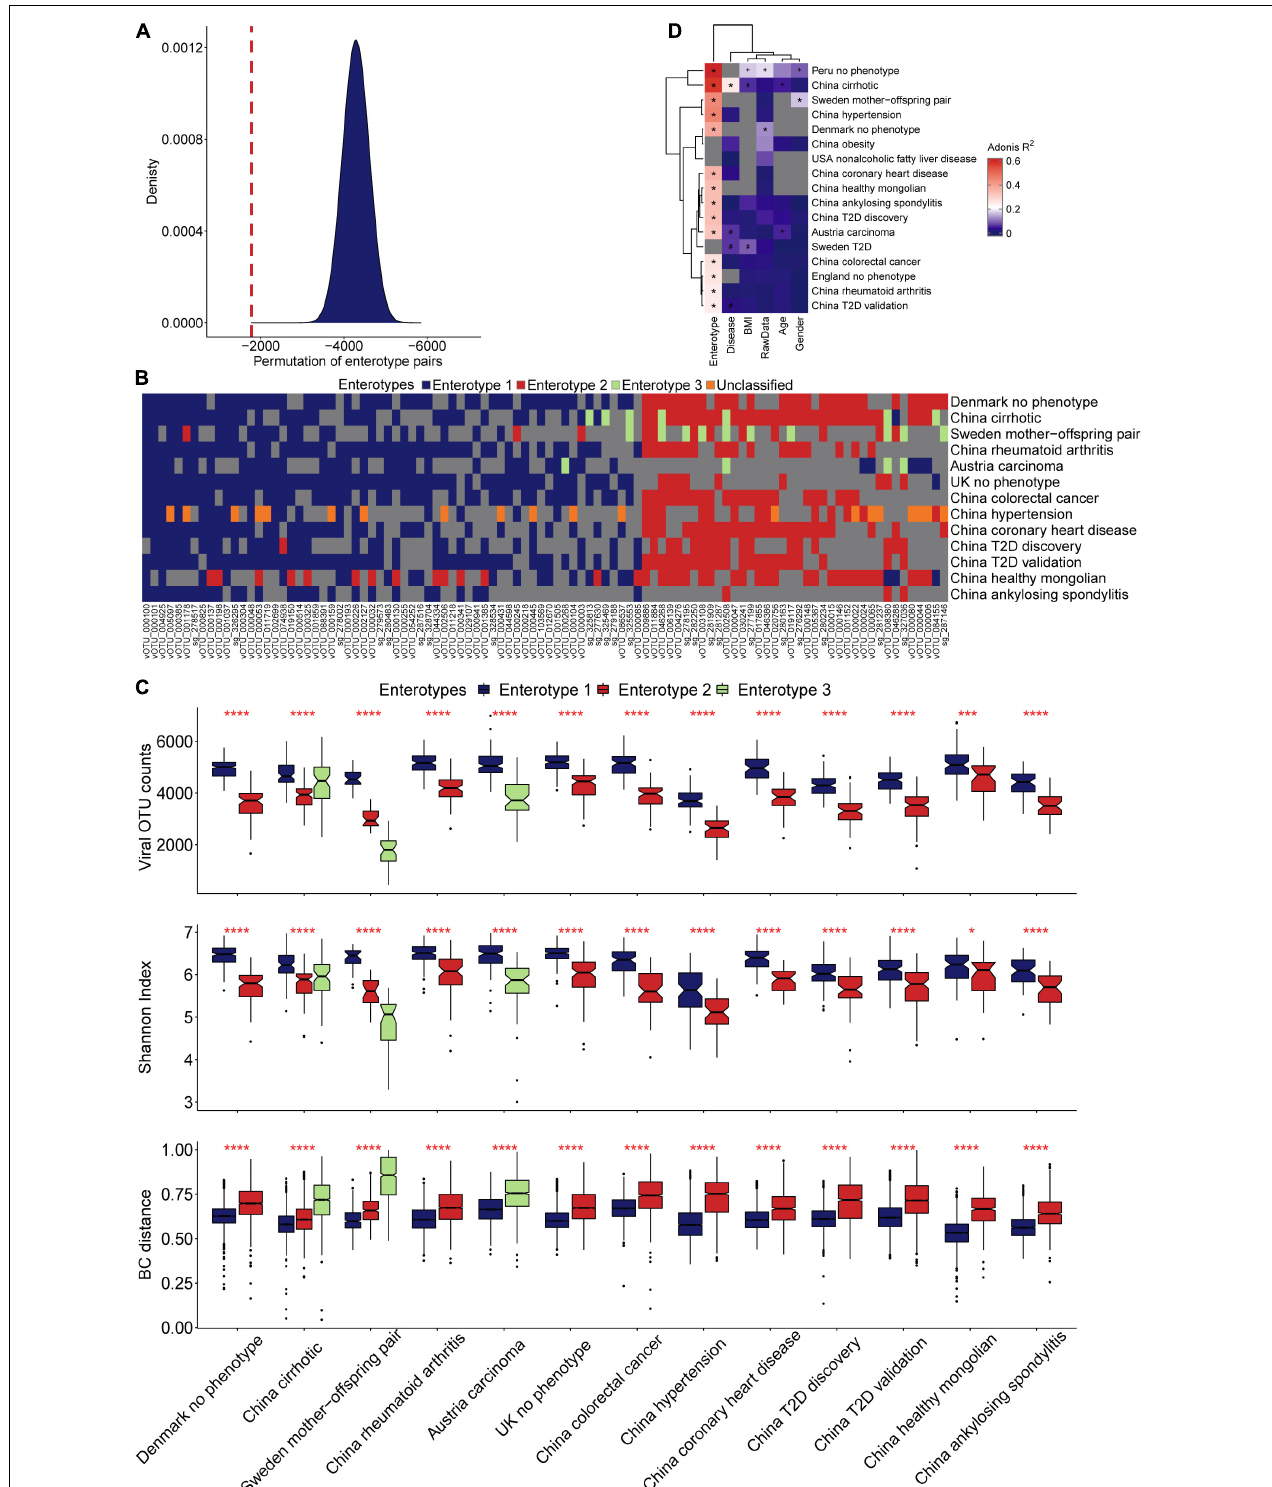
FIGURE 4 | Characterization of viral enterotypes in all projects. (A) We used the random pairing method to confirm the accuracy of artificial enterotype classification. The density map shows the score distribution of 5 million permutations, and the red line indicates the score of the manual category. (B) The categories of manual enterotypes in different projects show a high concordance of their specific vOTUs and enrichment direction. (C) Ecological diversity of different viral enterotype populations. (D) Effect of different covariates on the structural variance of the gut virome community.